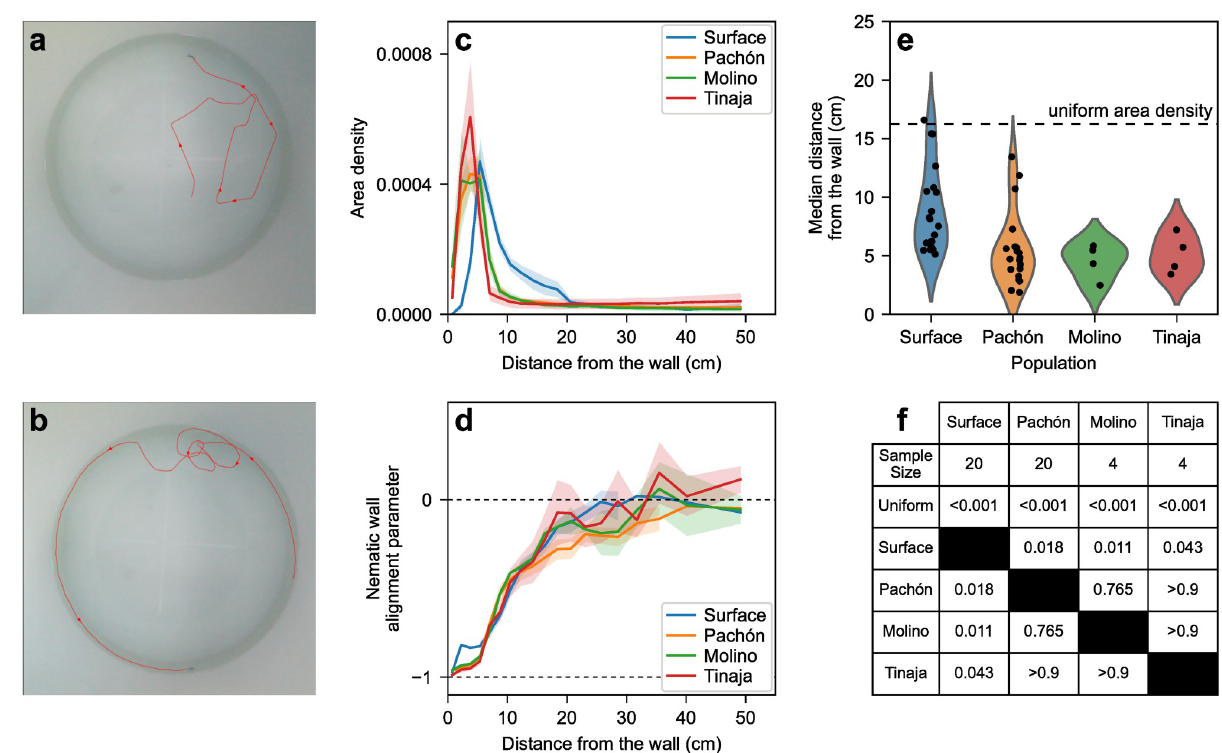
Fig 1. (a) Snapshot from a video of a single surface fish. The red line is the trajectory over the 25 seconds leading to the snapshot. (b) Similar snapshot and 25 s-trajectory from a video of a single Pacho´n cavefish. (c) Fish density probability per unit area as a function of the distance from the wall for single fish trials for each population. The distance varies between 0 cm (right against the wall) and 55.5 cm (center of the tank). The halo around each curve corresponds to one standard error on either side of the mean. (d) Average nematic alignment parameter relative to the wall (cos(2 θ ) where θ is the angle between the fish’s heading and the closest wall’s normal vector) as a function of the distance to the wall. Values near -1 indicate strong alignment parallel to the wall. Values near 0 suggest no favored orientation. The halo around each curve corresponds to one standard error on either side of the mean. (e) Median distance from the wall in each trial, by population. The dashed line is the median distance with a uniform area density (tank radius ffiffiffi p times ð 1 (cid:0) 1 = 2 Þ ; half of the tank’s area is within that distance of the wall). (f) Median distance from the wall statistics. Every population is different from the uniform case (Shapiro test, then T-test if normal or Wilcoxon test if not, N Su = 20, N Pa = 20, N Mo = 4, N Ti = 4, p < 0.001 for every population). Cave populations are different from surface fish, but not from each other (Kruskal-Wallis test, p = 0.0015, then Games-Howell test, p Su − Pa = 0.018, p Su − Mo = 0.011, p Su − Ti = 0.043, p Pa − Mo = 0.765, p Pa − Ti > 0.9, p Mo − Ti >